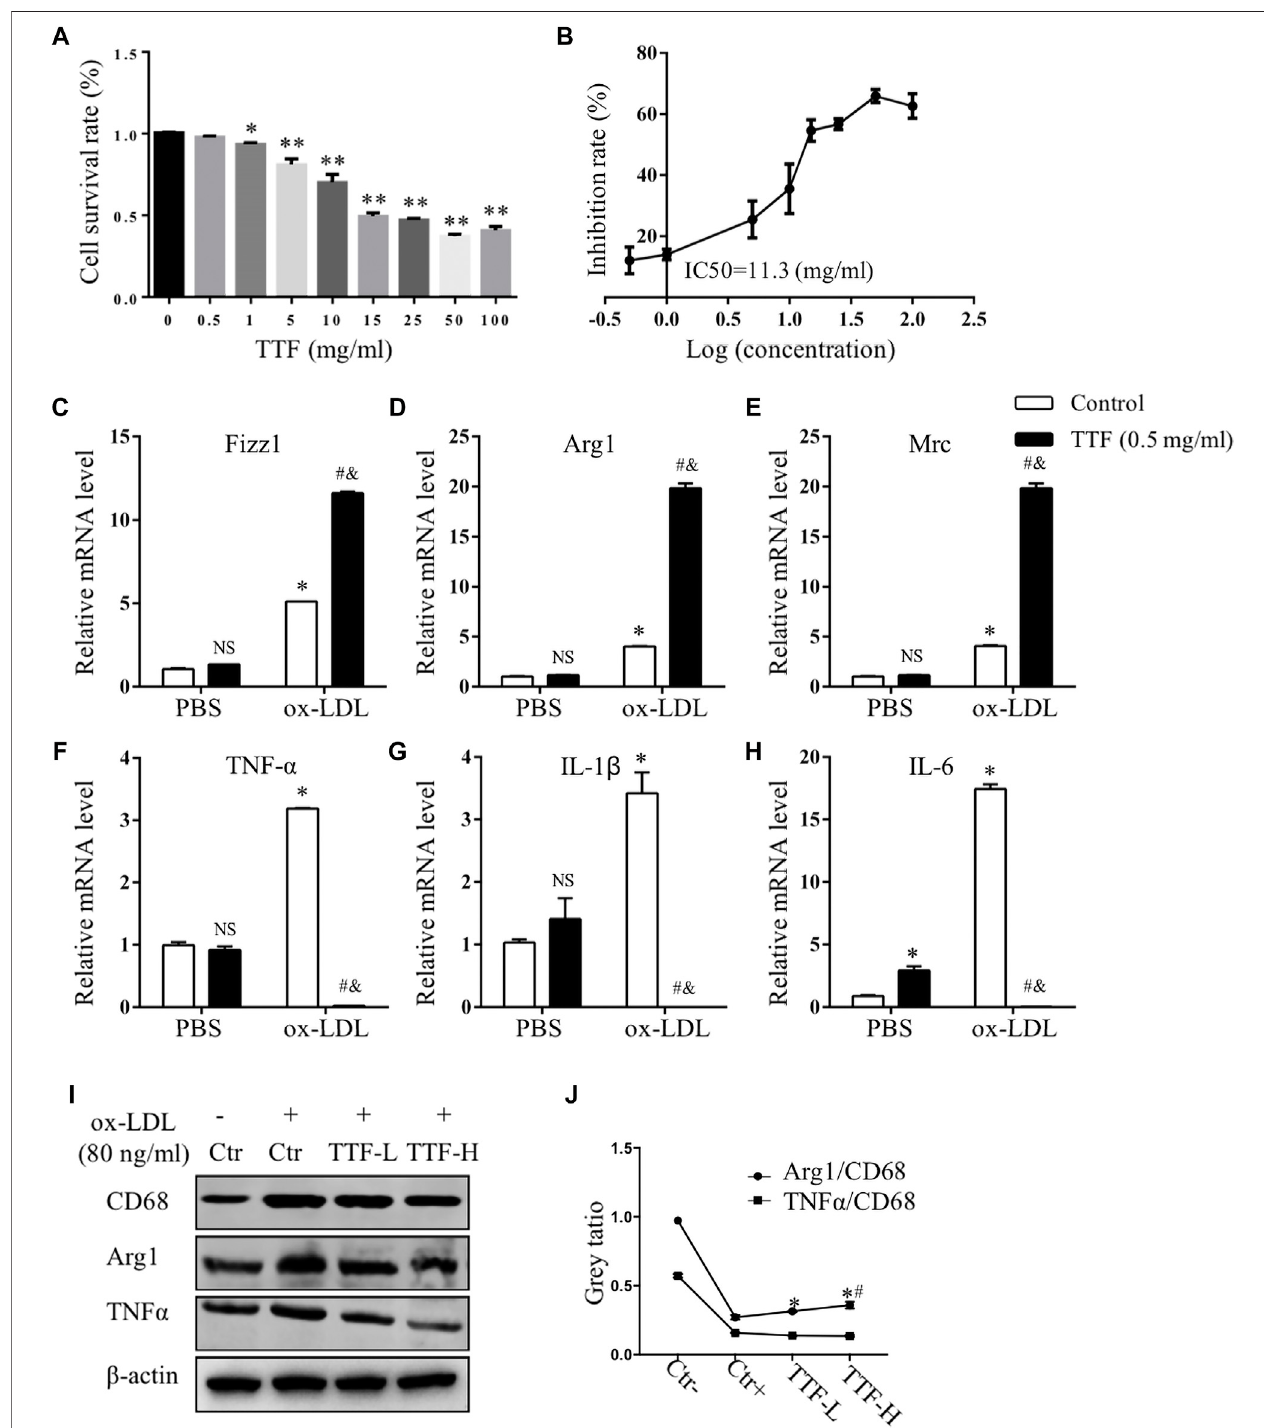
FIGURE6| TTFaffectedtheexpressionofmRNAofM1andalternativemacrophagemarkers.PMcellsisolatedfromApoE -/- miceweretreatedwith0.5 mg/mlTTF for24 hfollowedbyox-LDL stimulatingfor24 h (A) ThecellsurvivalrateofPMpretreatedwithTTFandIC50 ofPM (B) . * p < 0.05and** p < 0.01vsControl(TTF (cid:2) 0 mg/ ml) group (C – E) The mRNA expression of Fizz1, Arg1 and Mrc of alternative macrophage markers (F – H) The mRNA expression of TNF α , IL-1 β and IL-6 of M1 markers. The relative mRNA level was measured by RT-qPCR analysis. Values are presented as means ± SEM (n (cid:2) 3 per group). NS represents no signi fi cant with Control (PBS)group,* p < 0.05vsControl(PBS)group,# p < 0.05vsTTF(PBS)group,& p < 0.05vsTTF(PBS)group (I) WesternblottingshowedtheproteinexpressionofCD68, Arg1, and IL-6 in PM cells treated with PBS, TTF-L (0.25 mg/ml), and TTF-L (0.5 mg/ml) stimulated with ox-LDL (80 μ g/ml) (J) The quantitative analysis of grey ratio of Arg1/CD68 and TNF α /CD68. Values are presented as means ± SEM (n (cid:2) 3 per group). * p < 0.05 vs Ctr + group, # p < 0.05 vs TTF-L group.